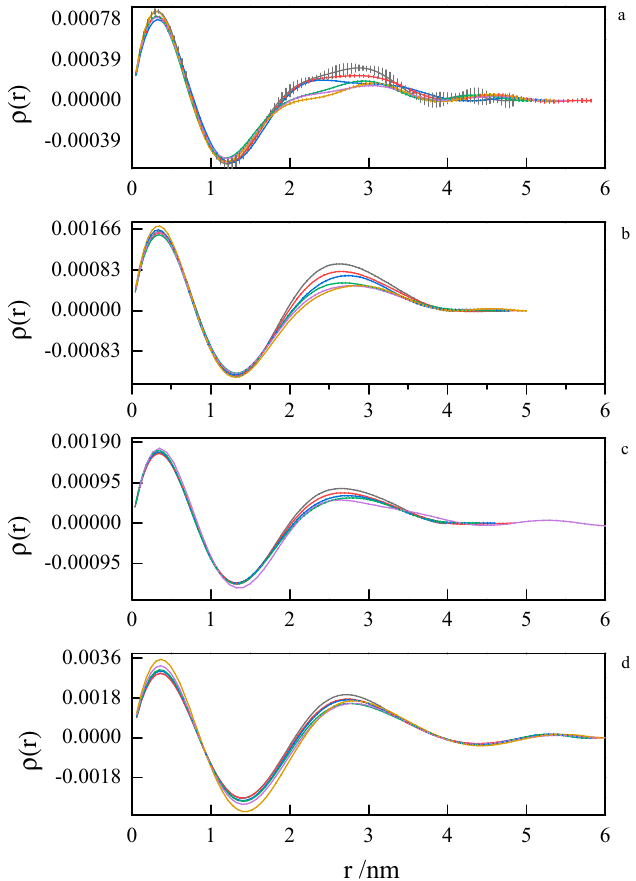
Figure 14. Pair distance distribution functions derived from SAXS data by indirect Fourier transform for 8-8-8 surfactant system at concentrations ( a ) 0.104 mol dm − 3 , ( b ) 0.171 mol dm − 3 , ( c ) 0.197 mol dm − 3 , ( d ) 0.342 mol dm − 3 at 293.15 K, 298.15 K, 303.15 K, 308.15 K, 313.15 K, 318.15 K.